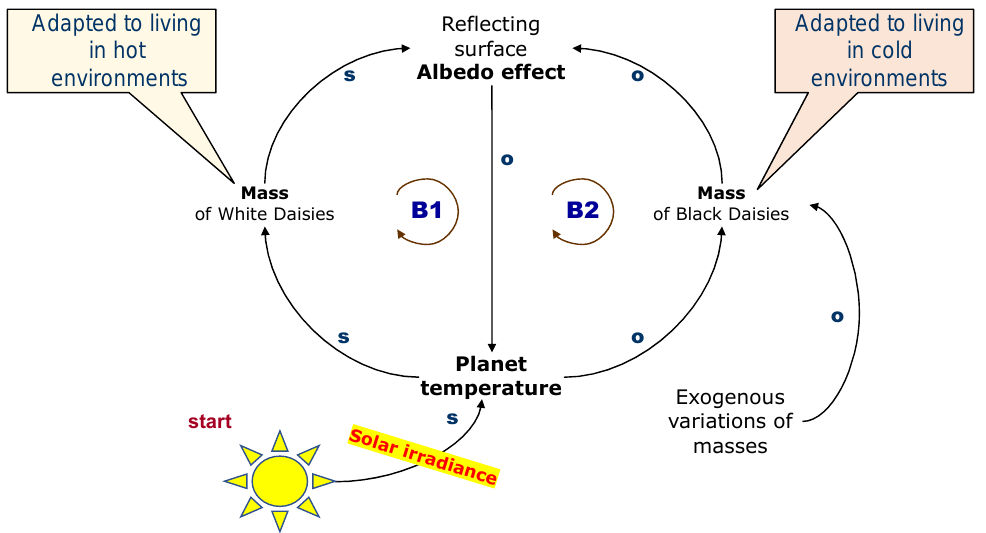
Figure 1. Metaphor of Daisyworld and process of self-regulation. The choice of black and white daisies was necessary to highlight their role in produc- ing the albedo effect; models have also been developed in which black and white daisies have been replaced by masses of grey daisies, but these models are not very effective. As much as the model in Figure 1 seems innovative and, in a sense, striking for its effective- ness and simplicity, in fact, “there is nothing new” in it; it simply describes a “two - lever”